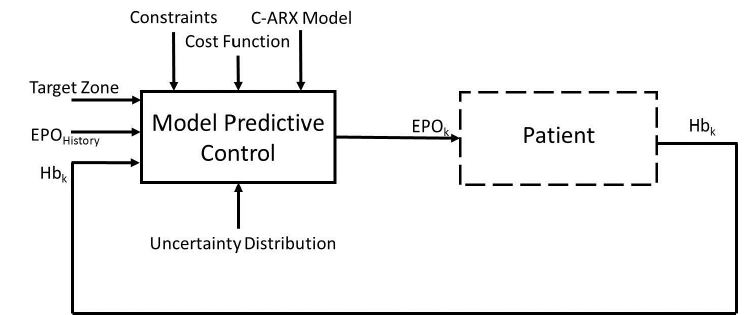
Figure 1. Overall control block